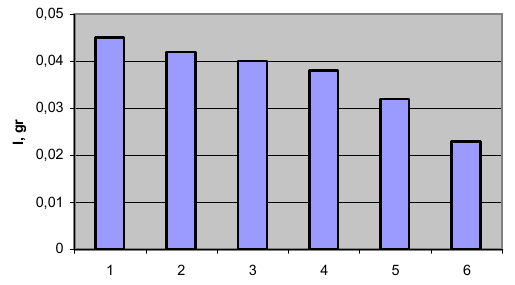
Fig 4. The steel and coatings wear under abrasive conditions (Si0 2 ): 1 - steel 30; 2 - PI8; 3 - graphite; 4 - 30X Г CA; 5 - BK8; 6 -